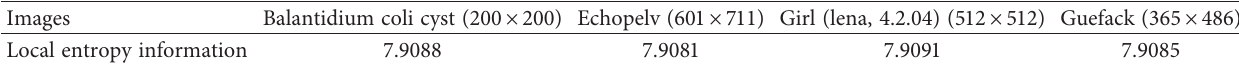
Table 9: Local entropies for the cipher